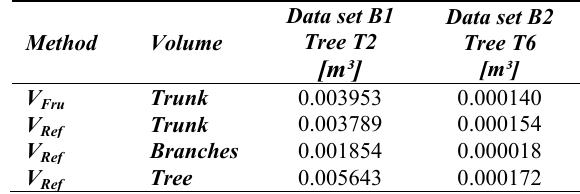
Table 2. Direct volume measurements of data set B; V Ref